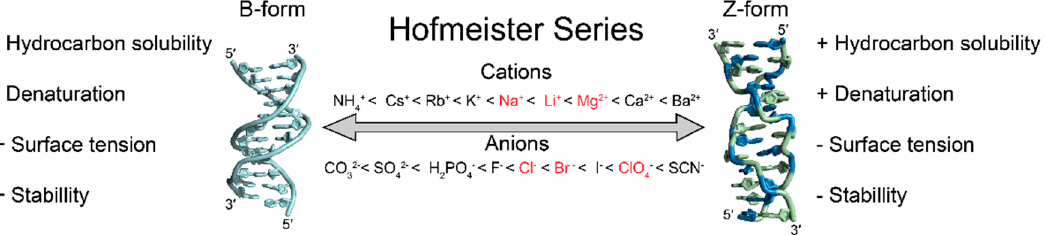
Figure 9. Hofmeister salts stabilize the Z-conformation. Hofmeister salts influence macromolecular structures by affecting hydrocarbon solubility, denaturation, surface tension, and stability [105–111]. The B-to-Z transition has been shown to be promoted by Hofmeister salts, although the direct cause has not been directly studied. Contributing factors may be due to differences in solvent accessible surface area or hydrophobicity between the right- and left-handed conformations or by promoting the Z-conformation through destabilization of the right-handed conformation. Ions highlighted in red can be definitively placed for salts affecting the A-to-Z transition as well [3,87,103].